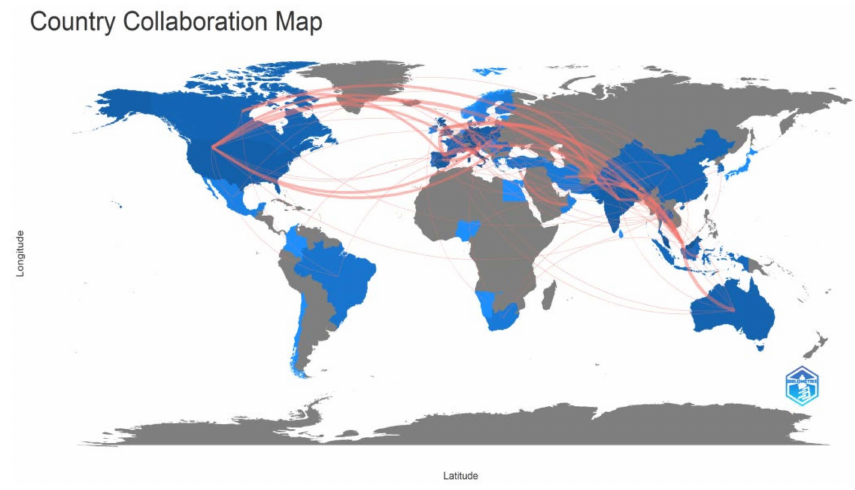
Figure 3. Social Structure of the Research.